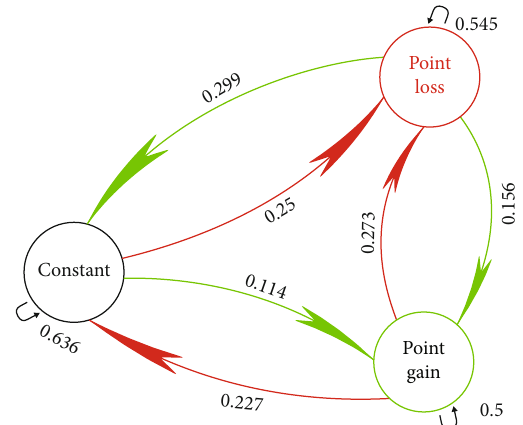
Figure 7: Enterprise Group Ltd. equity transition matrix and diagram.